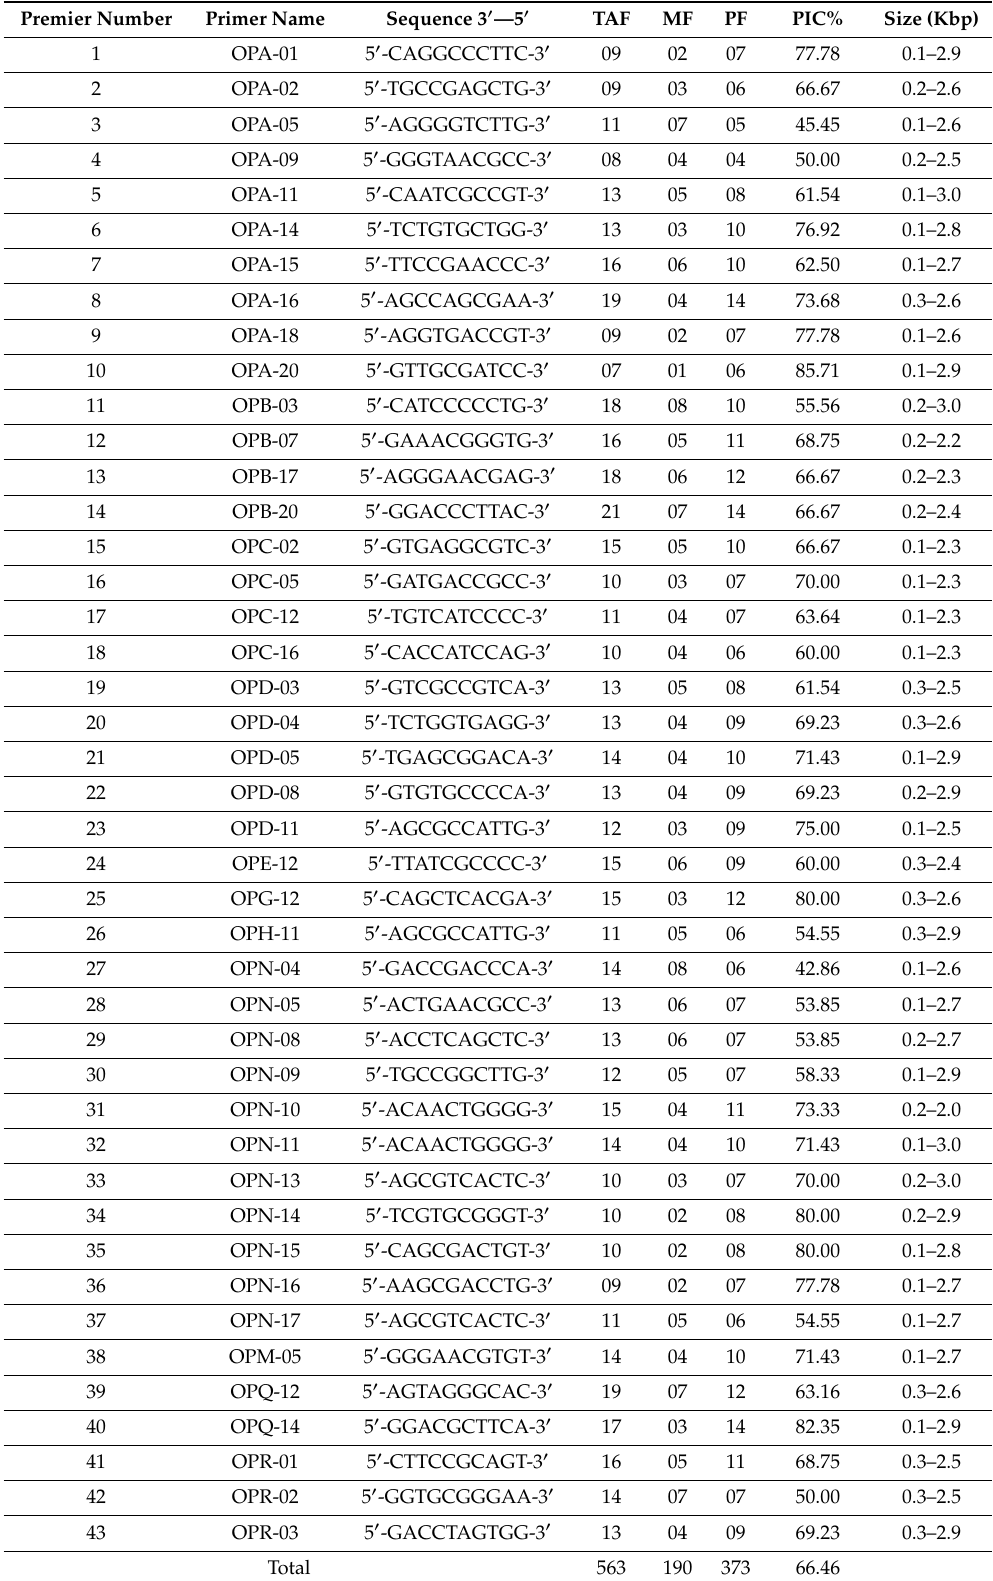
Table 4. Primer name, sequence, total number of amplified fragments and polymorphic percentage for Acacia species based on RAPD